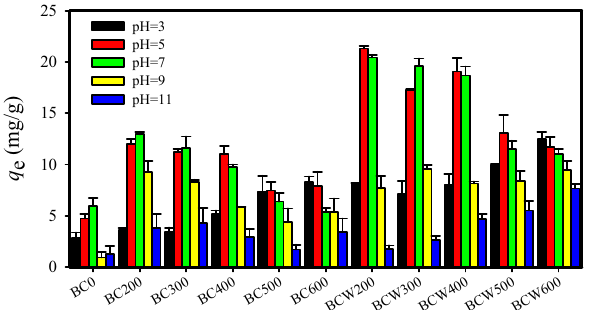
Figure 1. Effects of the pyrolysis temperature and pH on sorption of OFL by U.P -biochars. [Conditions] 20 mL of 20 mg/L OFL; 0.0150 g of U.P -biochar; 7 days. The experiment was conducted in